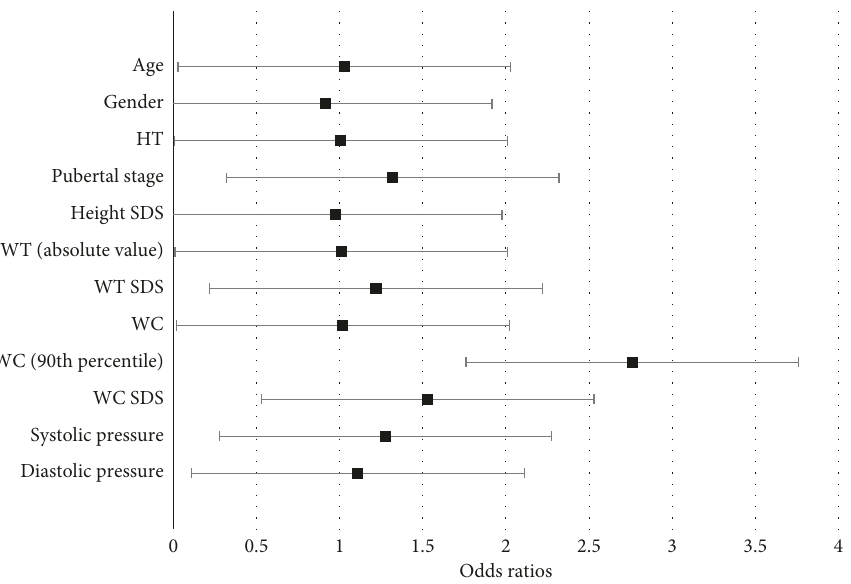
Figure 1: Bivariate logistic regressions between predictor variables and dyslipidemia.